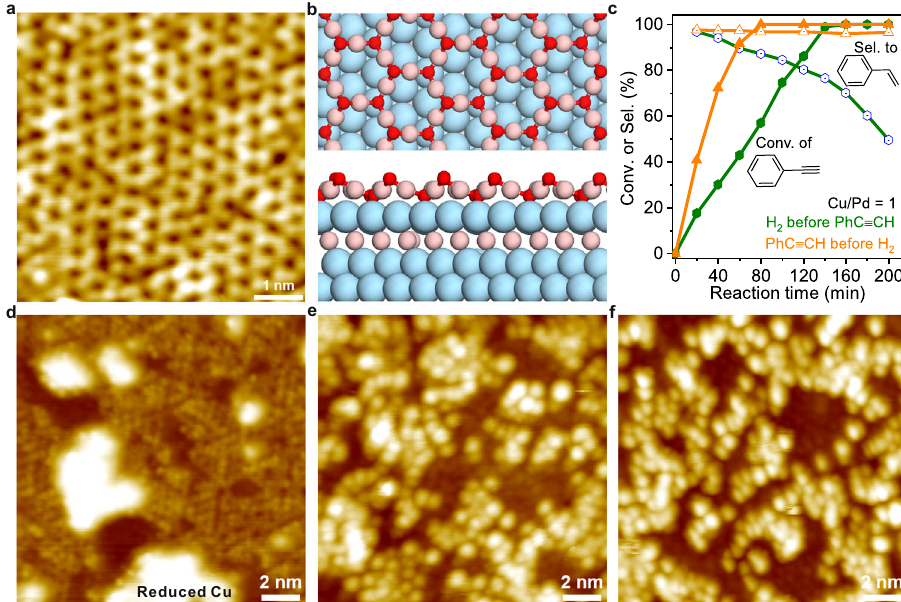
Fig. 2 Microstructure of PdCu@Cu 2 O and its redox dynamics. a STM images of PdCu@Cu 2 O with >1.0 ML Cu. b DFT-optimized structures of PdCu@Cu 2 O. c The difference in catalytic performance of PdCu@Cu 2 O (Cu/Pd = 1) nanosheets caused by the feeding sequence. d Exposure of PdCu@Cu 2 O (~1.0 ML Cu 2 O) with defects to 1.0 × 10 − 6 mbar H 2 at 300 K. e PhC ≡ CH adsorption on surface of PdCu@Cu 2 O (~1.0 ML Cu 2 O). f Exposure PdCu@Cu 2 O (~1.0 ML Cu 2 O) with adsorbed PhC ≡ CH to 1.0 × 10 − 6 mbar H 2 at 300 K. Reaction conditions: 10 mL ethanol; 2 μ mol Pd; 4 mmol PhC ≡